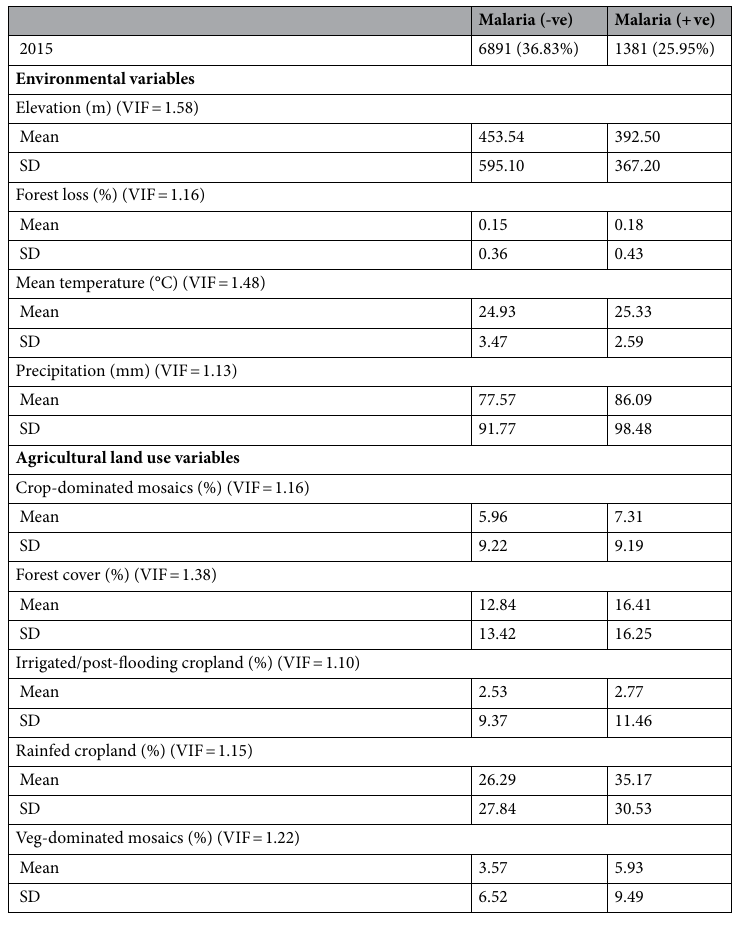
Table 1. Descriptive statistics. Descriptive statistics of all variables included in the geo-referenced dataset. VIF denotes Variance Inflation